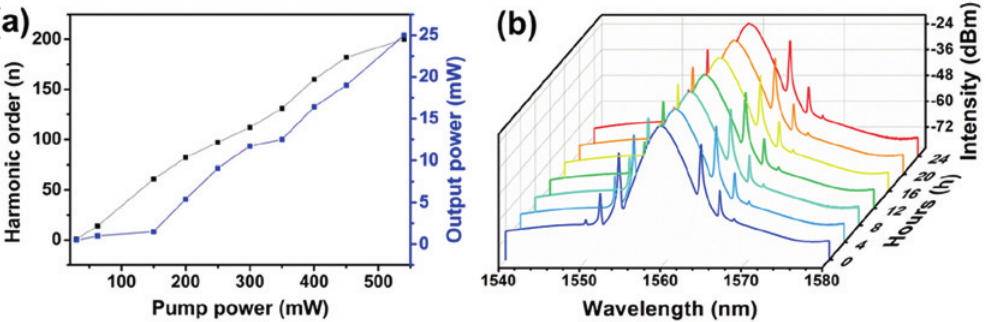
Figure 6: Output performance based on V 2 CT x . (a) Harmonic order and output power versus pump power. (b) Spectrum by increasing